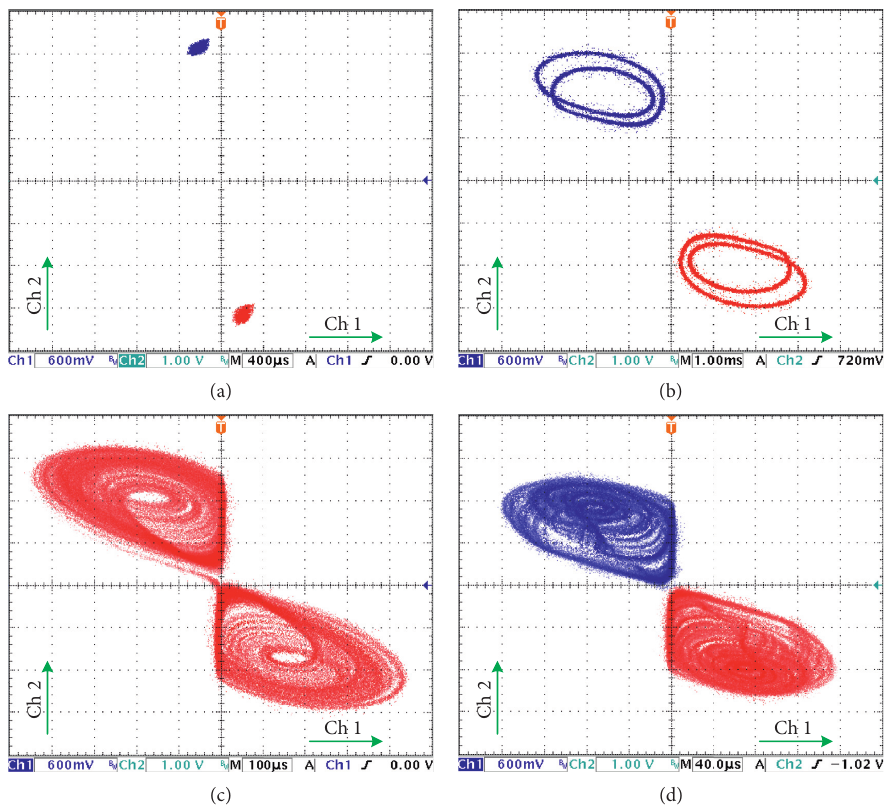
Figure 10: Experimentally captured trajectories in the v L � 10 mH. (b) Coexisting limit cycles with period-2 for R 2 � 5.71k Ω and L � 10 mH. (c) Double-scroll chaotic attractors for R 2 � 4k Ω and L � 10 mH. (d) Coexisting single-scroll chaotic attractors for R 2 � 4k Ω and L � 6.27